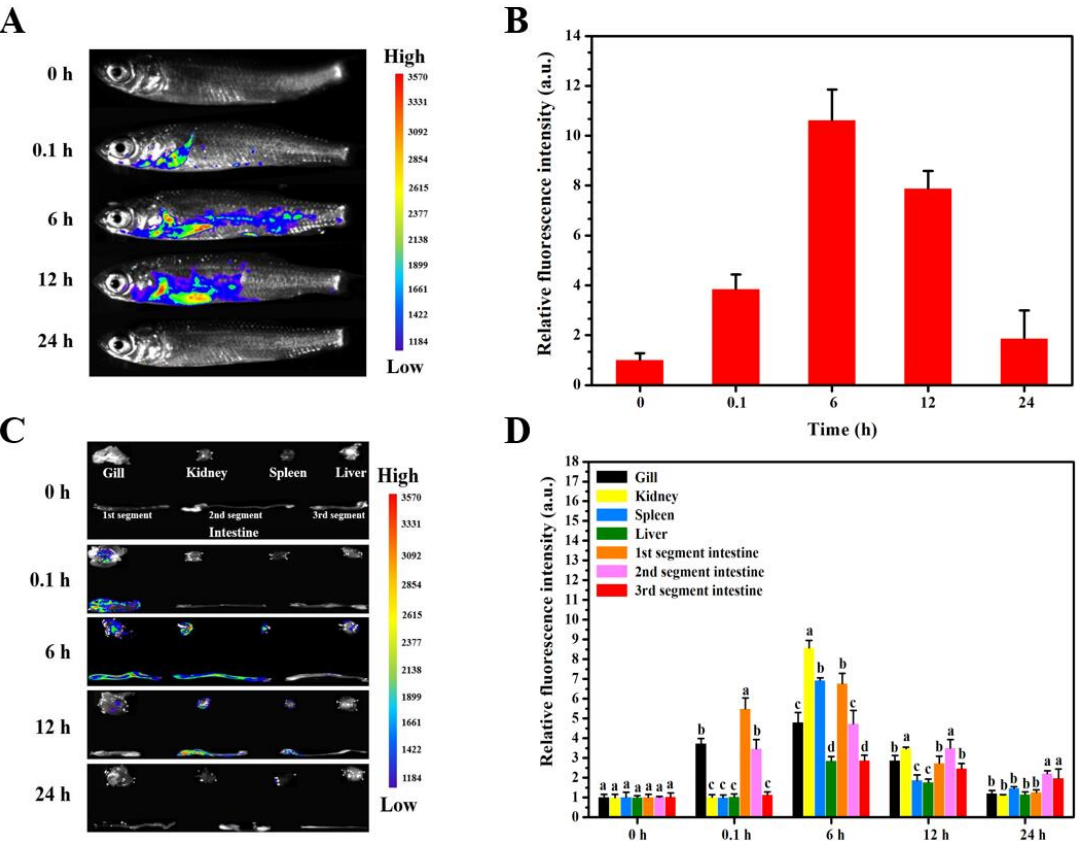
Figure 5. In vivo and ex vivo fluorescence images in vaccinated fish. ( A ) Representative in vivo fluorescence images for grass carp taken at different time points after vaccination; ( B ) Quantitative fluorescence signals of vaccinated fish; ( C ) Representative ex vivo fluorescence images of isolated fish tissues at five different time points; ( D ) Quantitative fluorescence signals of different fish tissues. Different colors in (A) and (C) represent the fluorescence intensity of FITC-CNTs-M-VP7 nanovaccine. The fluorescence intensity increases successively from purple to red. Data are means for three assays and represented as mean ± SD. p values were calculated by Duncan’s test. Data at the same sampling time with different letters (a, b, c, and d) are significantly different ( p < 0.05).